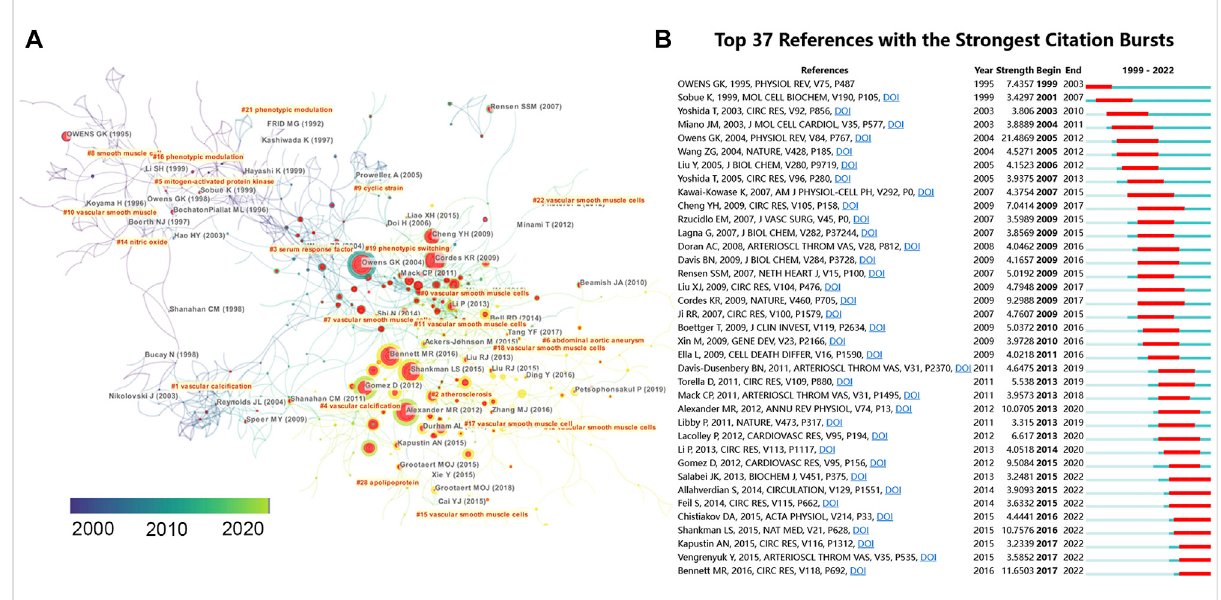
FIGURE 6 (A) Reference co-citation network identi fi ed by CiteSpace. The nodes and links are distinguished by colors, in which blue re fl ects an earlier co- citation relationship, yellow represents a recent co-citation relationship. The size of nodes is positively associated with the citation number. The red nodes represent the publication has burst change which may connect authors in different sub-domains in a given fi eld. (B) The top 37 co-cited references with the strongest citation bursts represent important publications in different periods. The red bar indicates the burst duration. The burst strength suggests the importance to the research fi